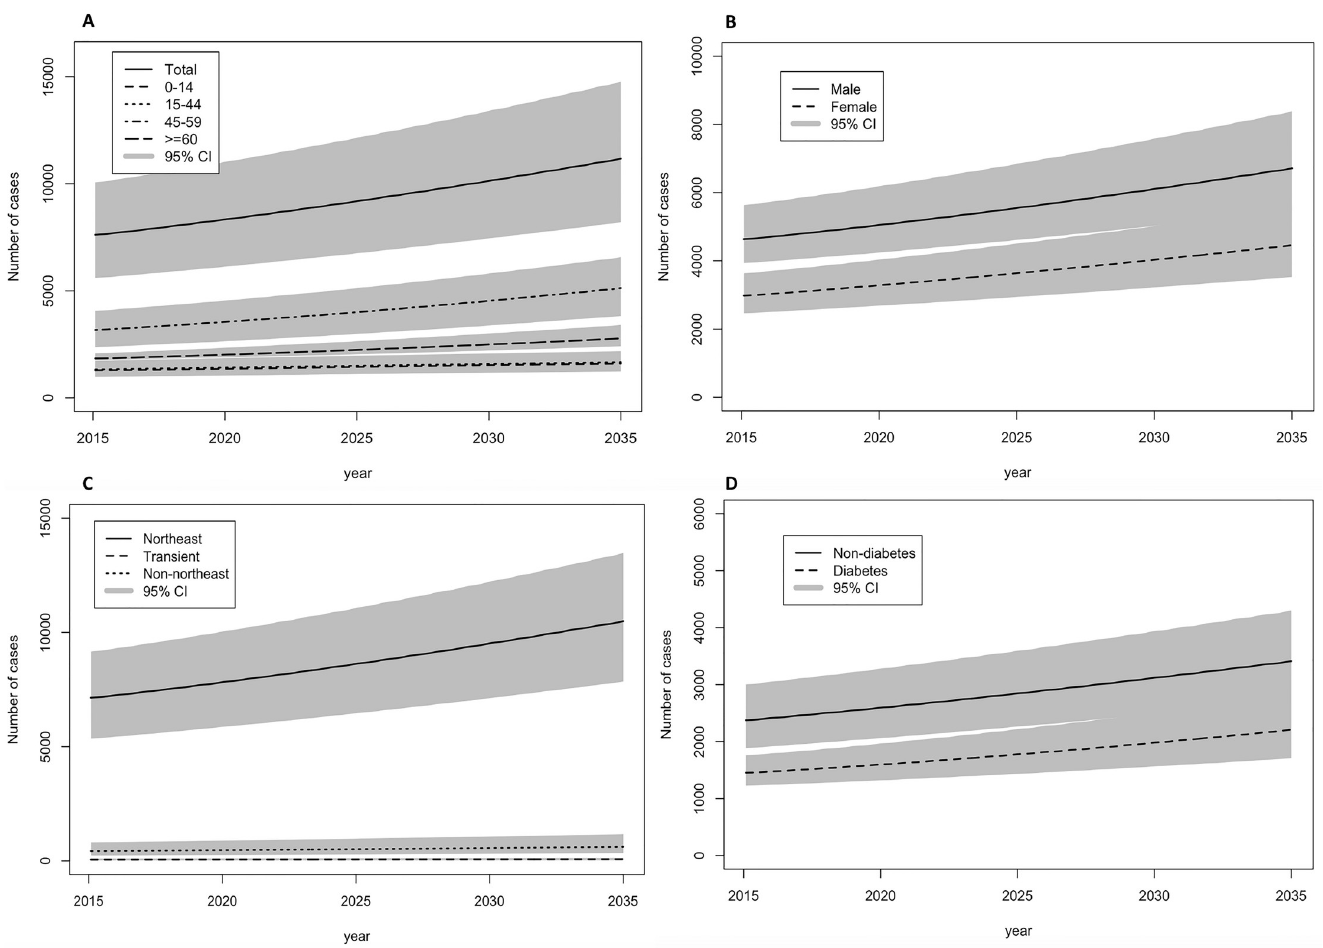
Fig 3. Projections of the numbers of melioidosis cases (95% credible intervals) between 2015 and 2035 in Thailand: (A) By age class (B) By gender (C) By geographical area, and (D) By diabetes status.